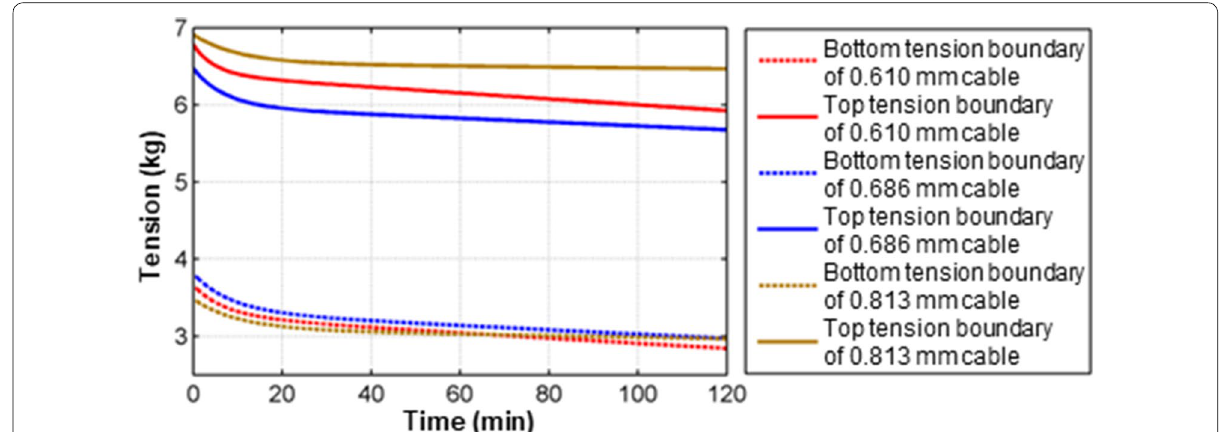
Figure 6 Fitting curves of cables of diameters 0.610, 0.686, and 0.813 mm